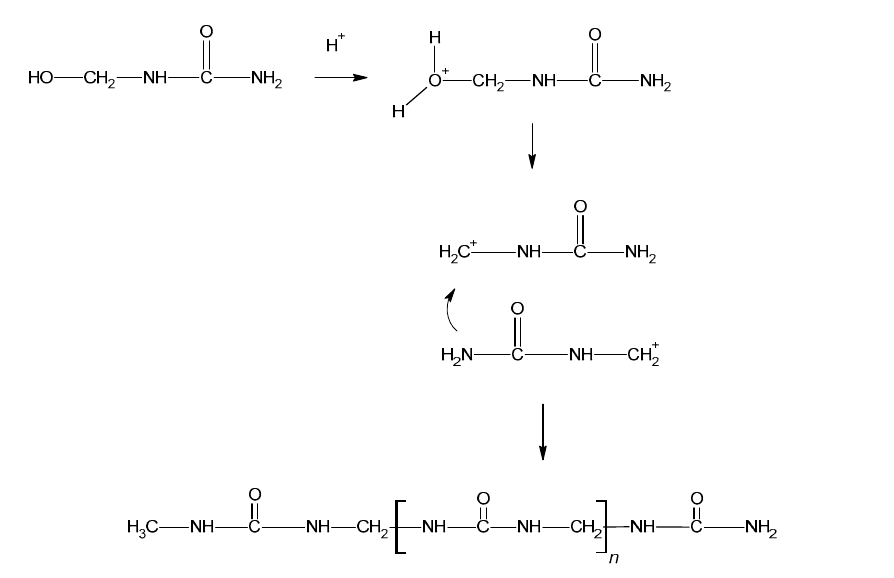
Figure 2. Copolymerization of monomethylolureas.